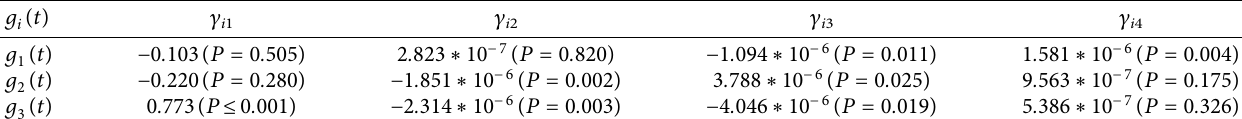
Table 4: Regression results of the three-species Lotka–Volterra